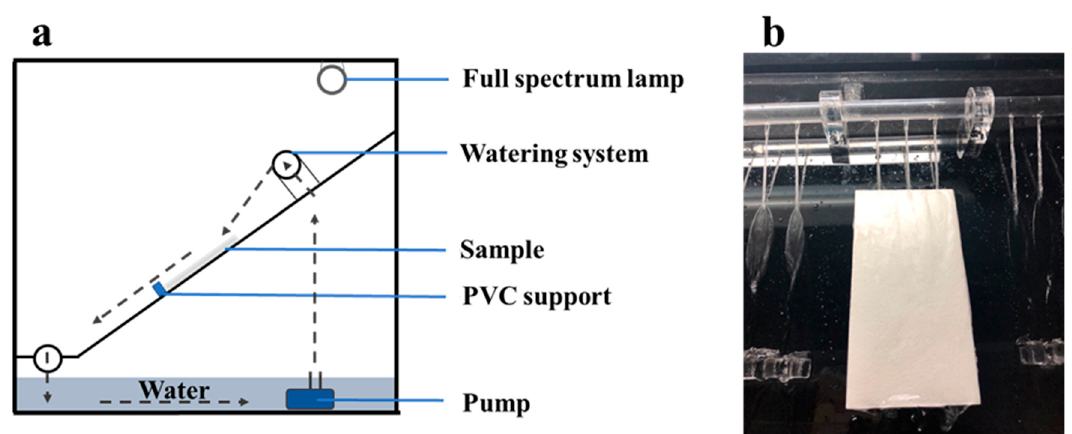
Figure 11. Washing test: ( a ) Schematic diagram; ( b ) top view of the washing test.